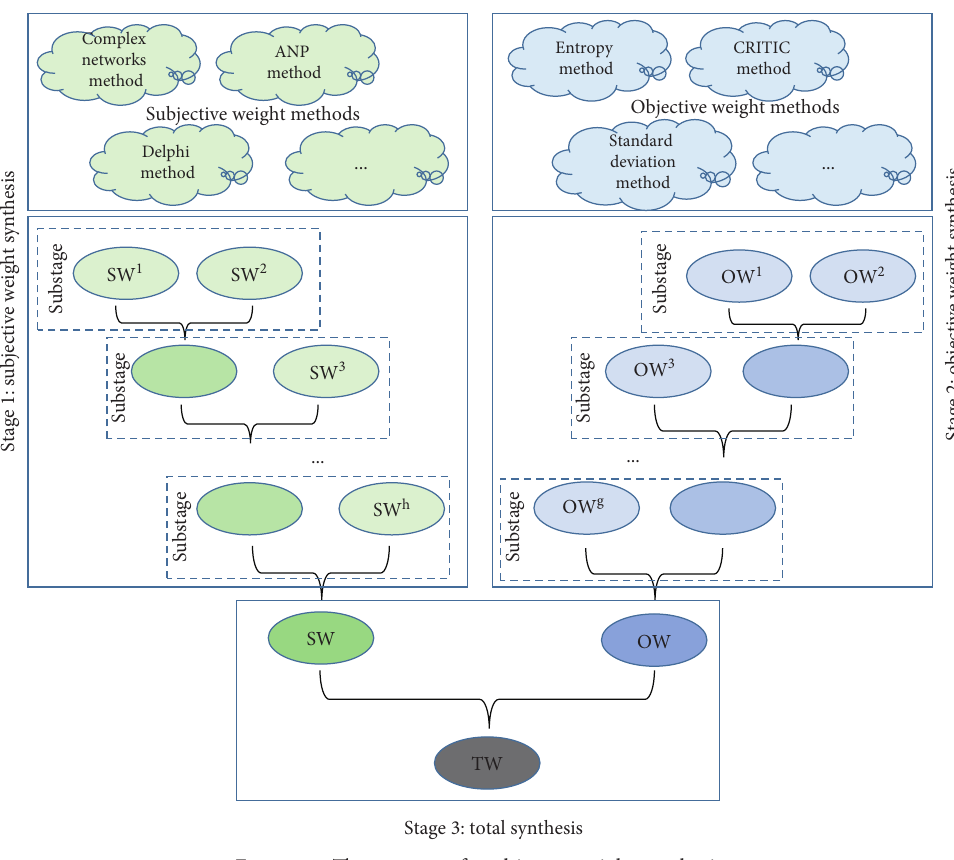
Figure 7: The process of multistage weight synthesis.